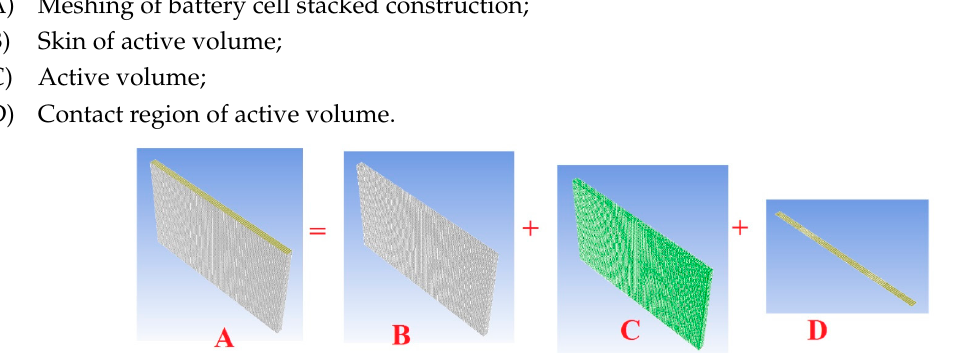
Figure 3. Battery cell geometry, which was analysed in this investigation.